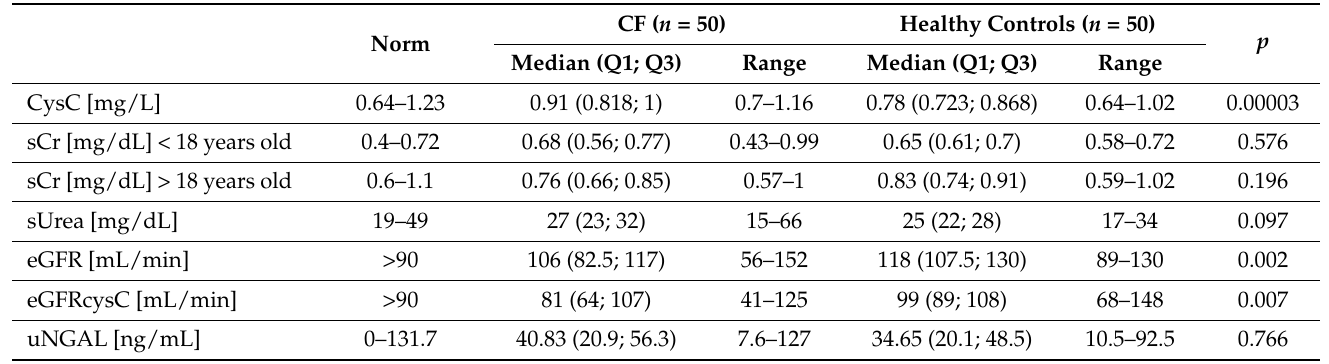
Table 2. Parameters of renal function of the study participants *.